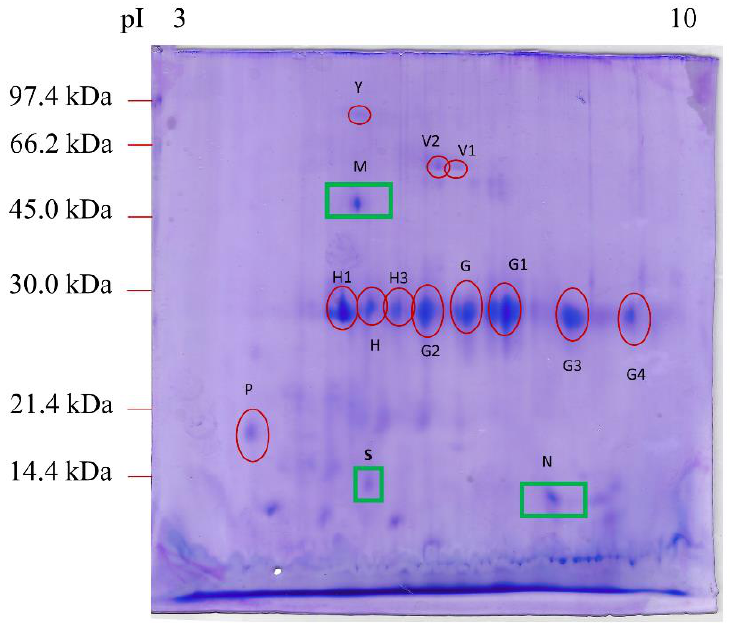
Figure 1. 2DE proteomic map of feces from dogs affected by intestinal lymphangiectasia. The protein spots marked with a red circle were expressed in the feces of both healthy dogs (Cerquetella et al., 2021) and dogs with IL. The protein spots marked with a green square were found only in IL-affected CAI feces. The proteins were separated on an immobilized pH 3–10 linear gradient strip and subsequently subjected to 13% SDS-PAGE. The standards were as follows: Bio-Rad low-molecular-weight phosphorylase b, 97.4 kDa; bovine serum albumin, 66.2 kDa; ovalbumin 45.0 kDa; carbonic anhydrase, 31.0 kDa; soybean trypsin inhibitor, 21.5 kDa; lysozyme, 14.4 kDa.